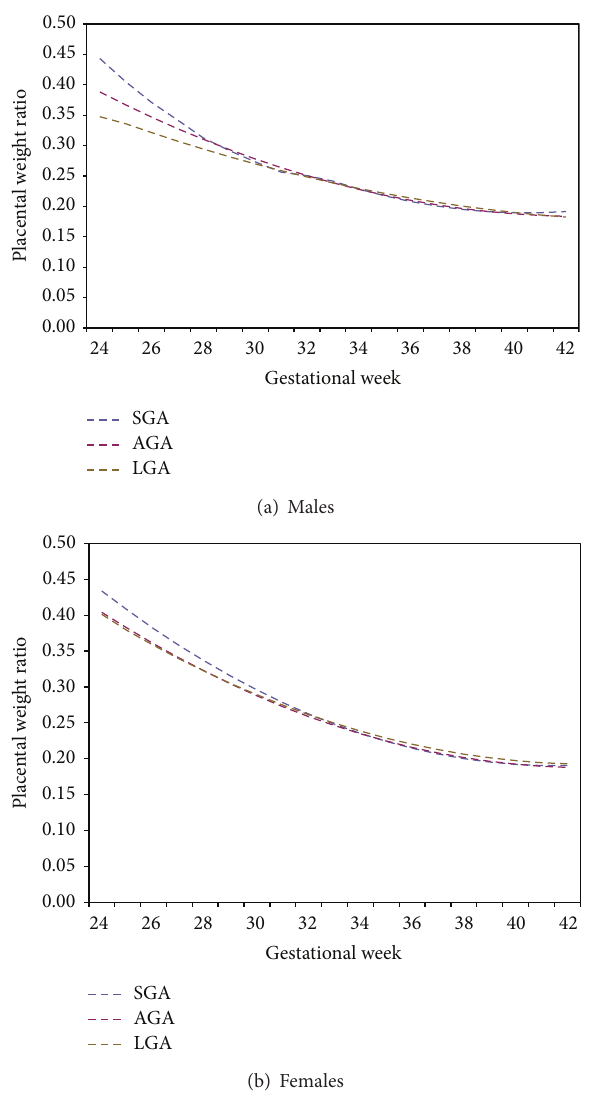
Figure 4: Inclusive of regional referrals SGA, AGA, and LGA median PWR distributions by gestational